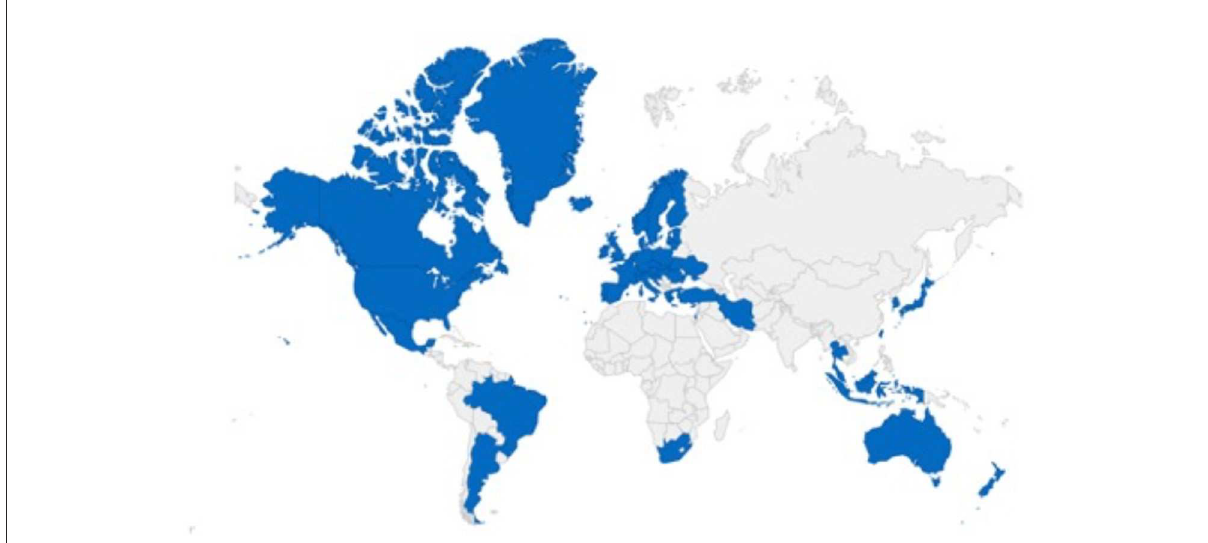
FIGURE1 Pharmaceutical Inspection Co-operation Scheme (PIC/S), the representative countries included in the Convention (9). The blue sections indicate the locations of representatives participating in the PIC/S GMP convention, and the gray areas indicate countries that do not participate in the PIC/S GMP convention and are therefore governed by other GMP